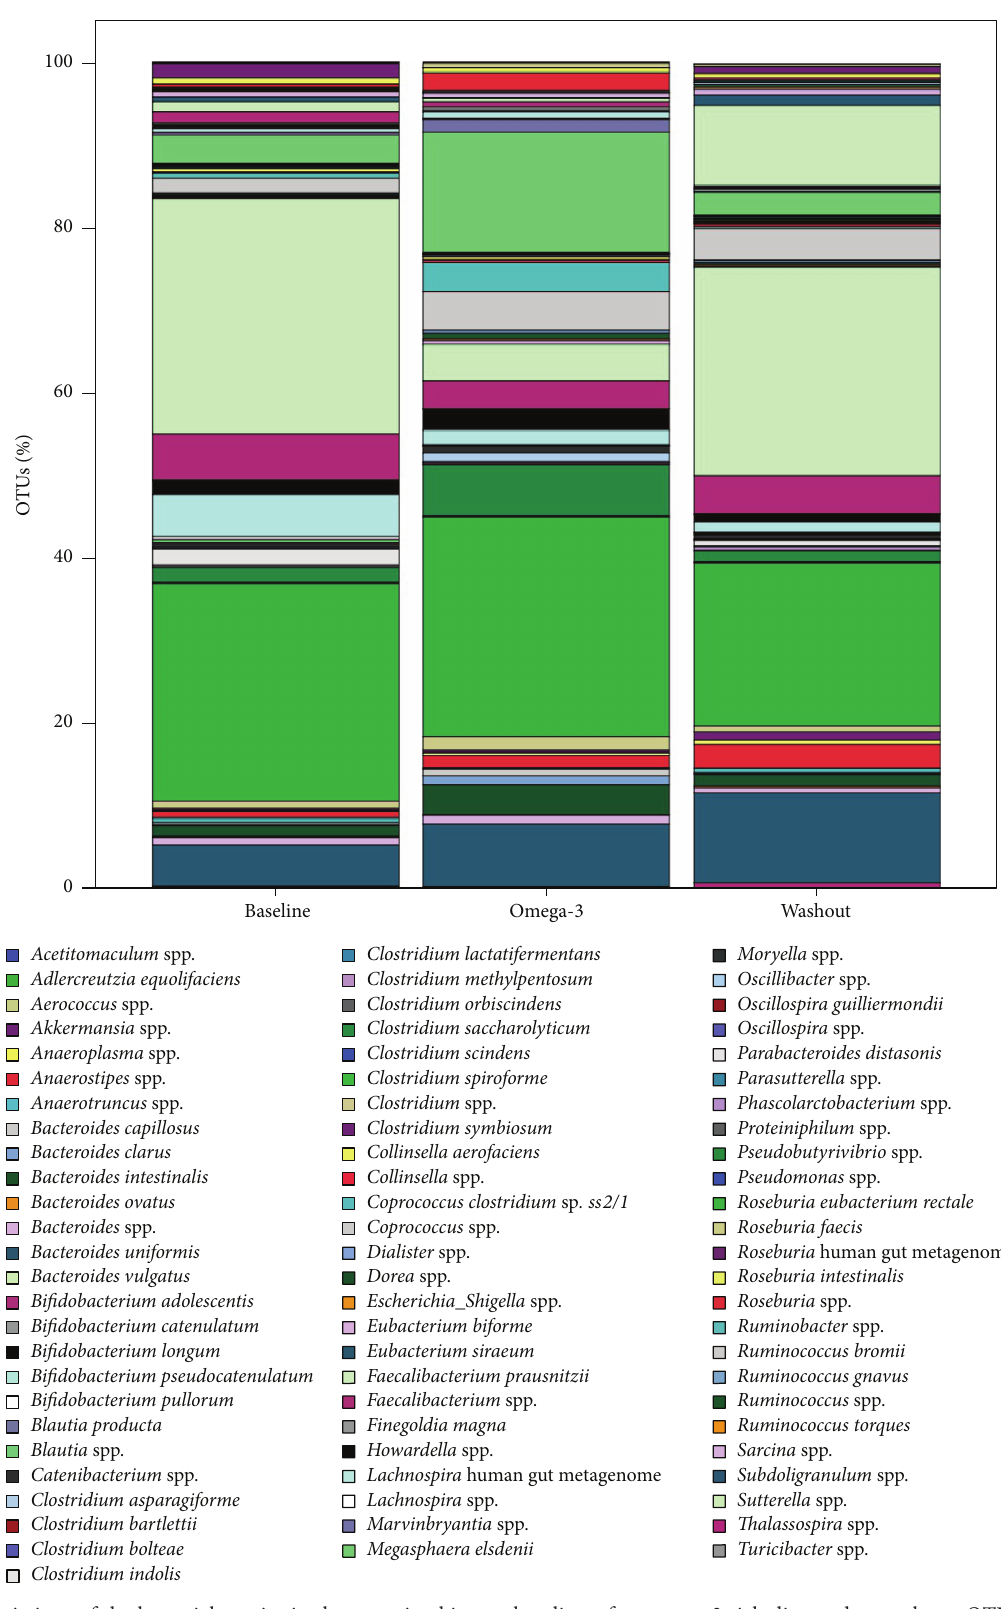
Figure 1: Variations of the bacterial species in the gut microbiota at baseline, after omega-3 rich diet, and at washout. OTUs: operational taxonomic